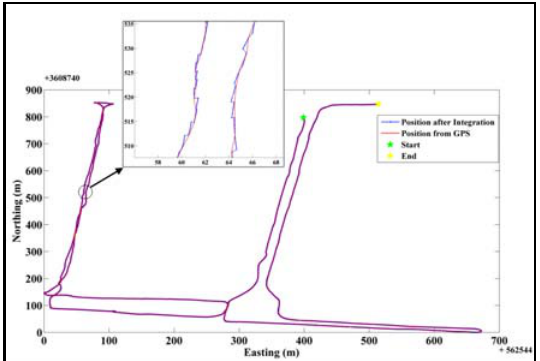
Figure 7. Test path before and after integration via EKF A few examples of traffic signs recognized in this road are depicted in Table 1. For each sign, its true 3D position is also measured manually by static DGPS. The results are compared with the coordinates derived from our system. The last columns show the absolute difference of the manually measured and automatically computed coordinates. The average values of the differences for all the test dataset are 0.110, 0.131 and 0.120 meters in three Cartesian directions of WGS84 reference system. The RMS error of positioning in X,Y and Z directions are 0.116, 0.136 and 0.125 meters respectively. As a result, 90% true positive recognition is achieved. Referring to Table 1, samples 6 and 8 are correctly detected even with partial occlusion; signs 1, 3, 4 are validly recognized even in spite of the disorientation and scaling problems; signs 3, 4, 5, 7 are also correctly recognized despite the illumination variations. All the programs are implemented by MATLAB programming on an Intel Core2 Duo CPU 2.2 GHz / 789 MHz. The detection process takes averagely 0.0285 seconds; the detection and recognition processes totally consume 0.4063 seconds; and extracting the 3D coordinate of an image point needs only 0.0002 seconds.